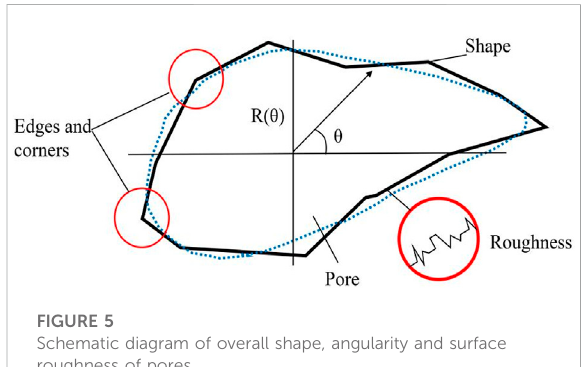
FIGURE 5 Schematic diagram of overall shape, angularity and surface roughness of pores. FIGURE 6